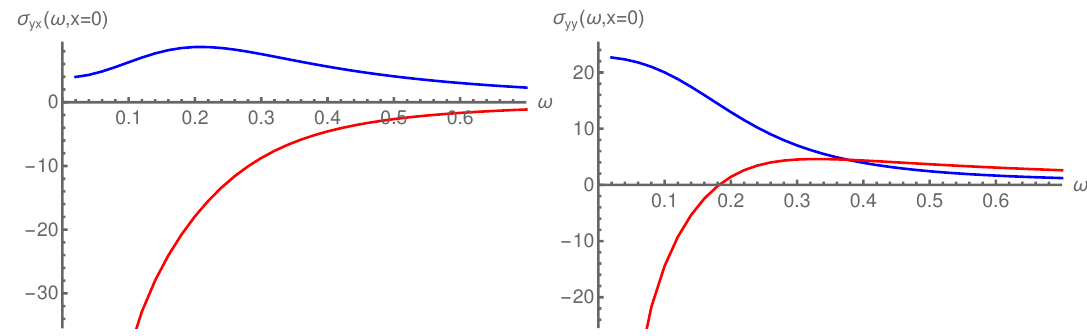
Figure 11 . The components of the conductivity (left) σ yx and (right) σ yy at b = 0 . 5 featuring spatially modulated delta functions at zero frequency, shown at x = 0 . Real parts are blue, and imaginary parts are red. Although the delta function in the real part is not accessible numerically, the corresponding pole in the imaginary part is